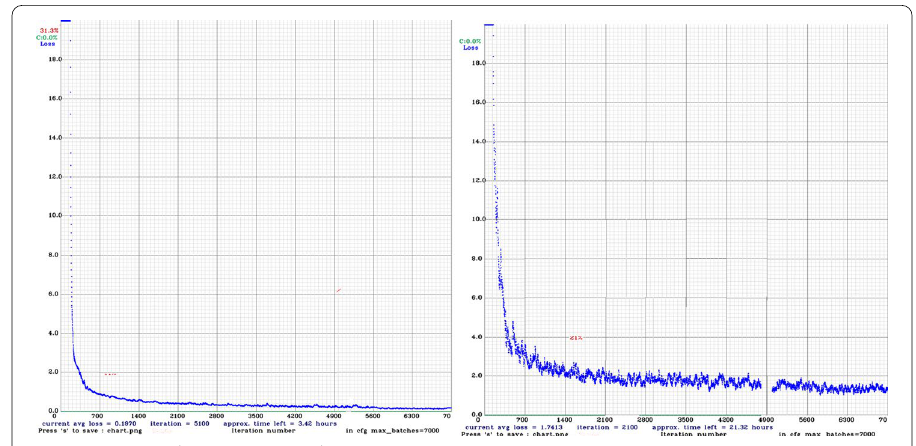
Fig. 6 YOLOv3 and YOLOv4 training loss on 7000